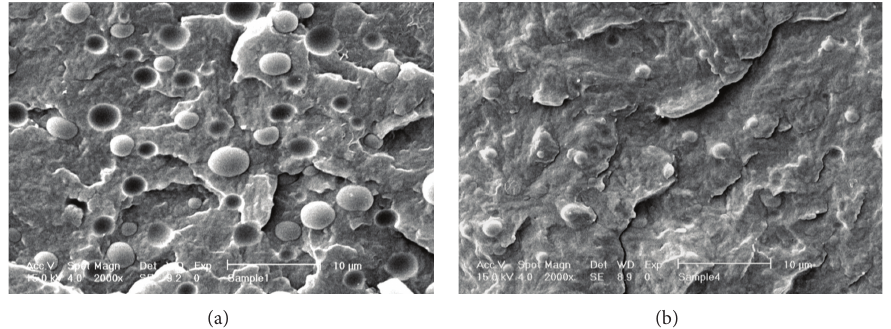
Figure 2: SEM micrographs of uncompatibilized and compatibilized blends (magnification: × 2000). (a) PP/PET/PP-g-MA: 80/20/0; (b) PP/PET/PP-g-MA: 73/20/7.